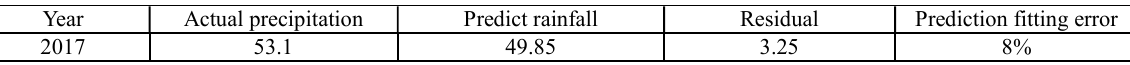
Table 9. Regression formula table of seasonal precipitation and temperature